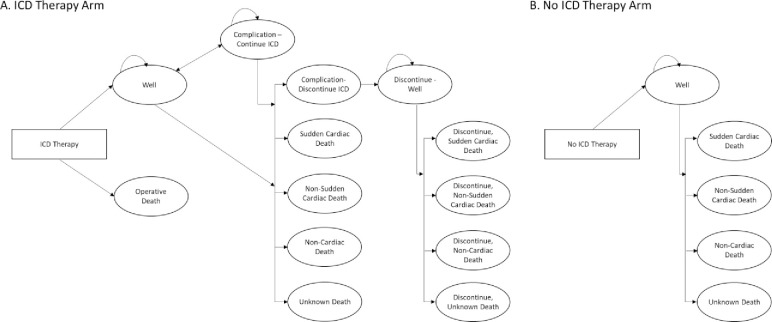
Model schematic.